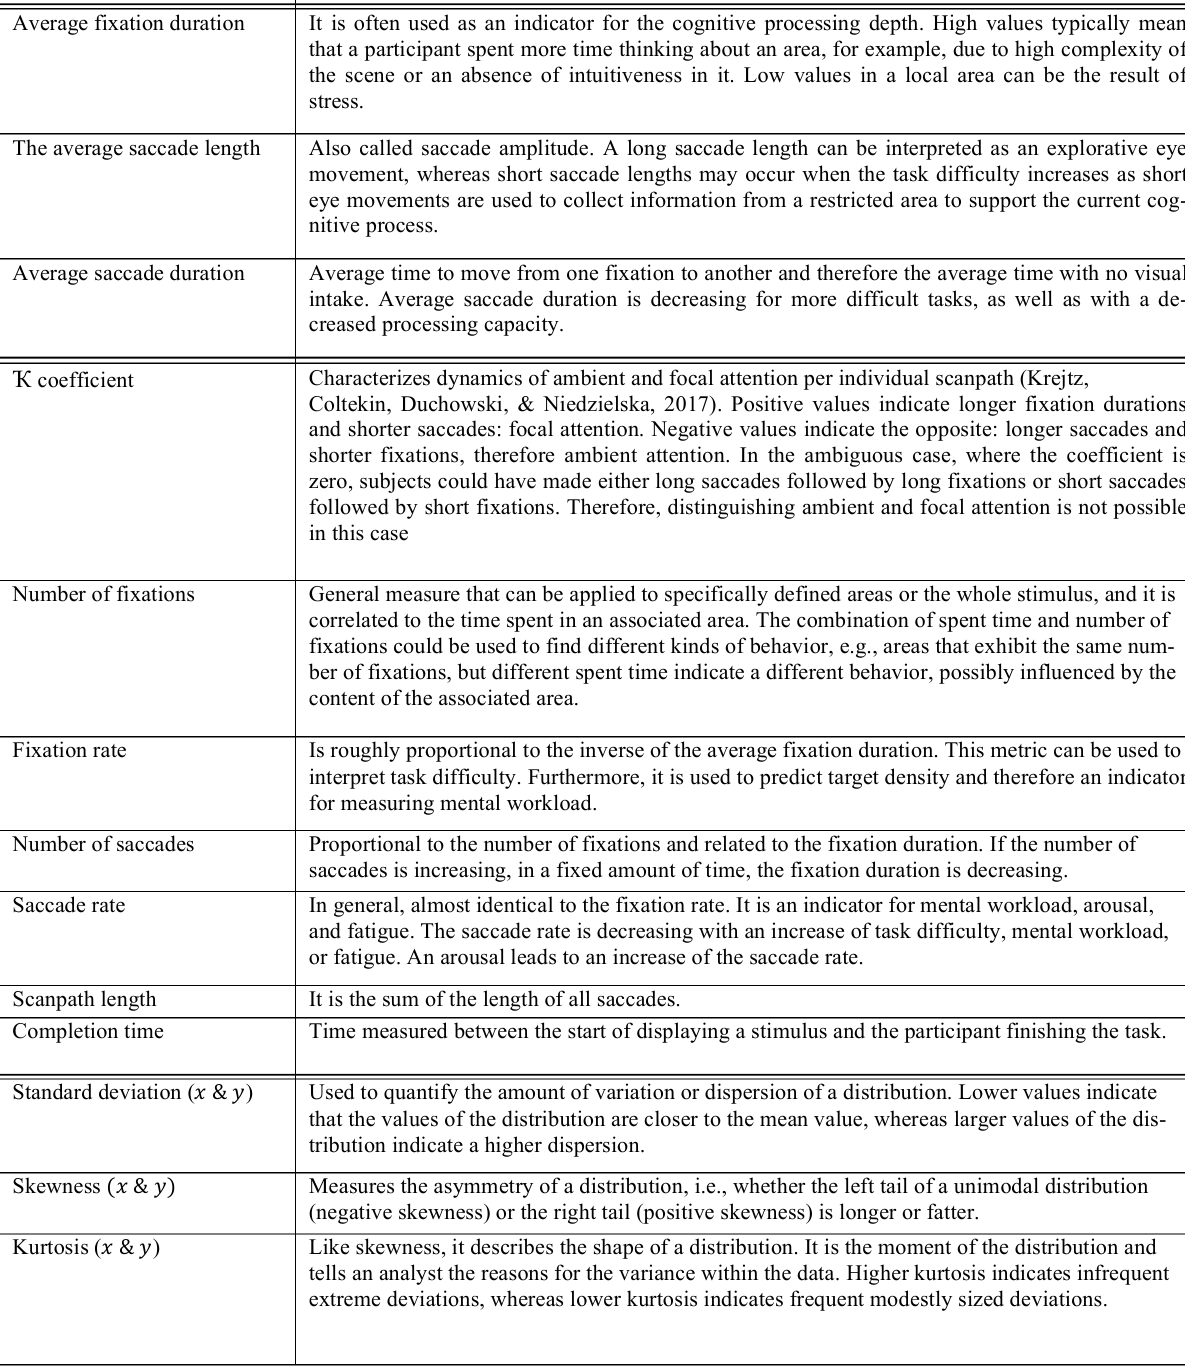
Used metrics are divided into three categories. The first group are eye-tracking metrics based on movement measures. The se- cond group are numerosity measures. The third group are statistical (position) measures of spatial distributions of fixation for 𝑥 − and 𝑦 − coordinates. These statistical measures allow an analyst to get an impression about the most prominent areas within stim-